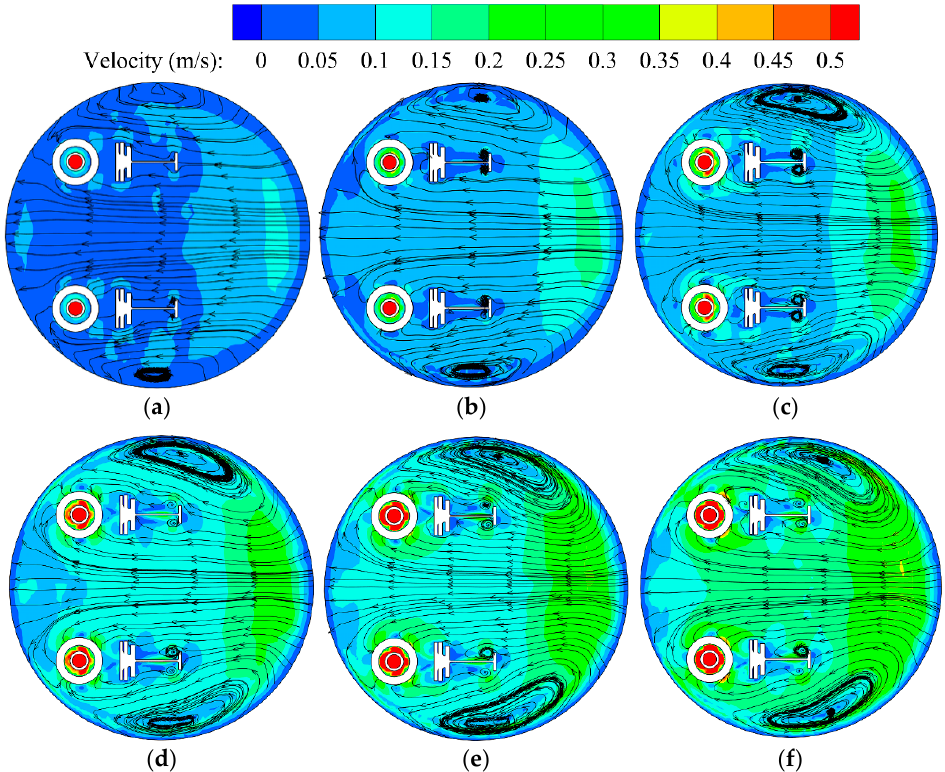
Figure 7. Cross-section A1 flow velocity and streamline distribution. ( a ) 0.33 Q d , ( b ) 0.67 Q d , ( c ) 1.00 Q d , ( d ) 1.33 Q d , ( e ) 1.67 Q d , and ( f ) 2.00 Q d .